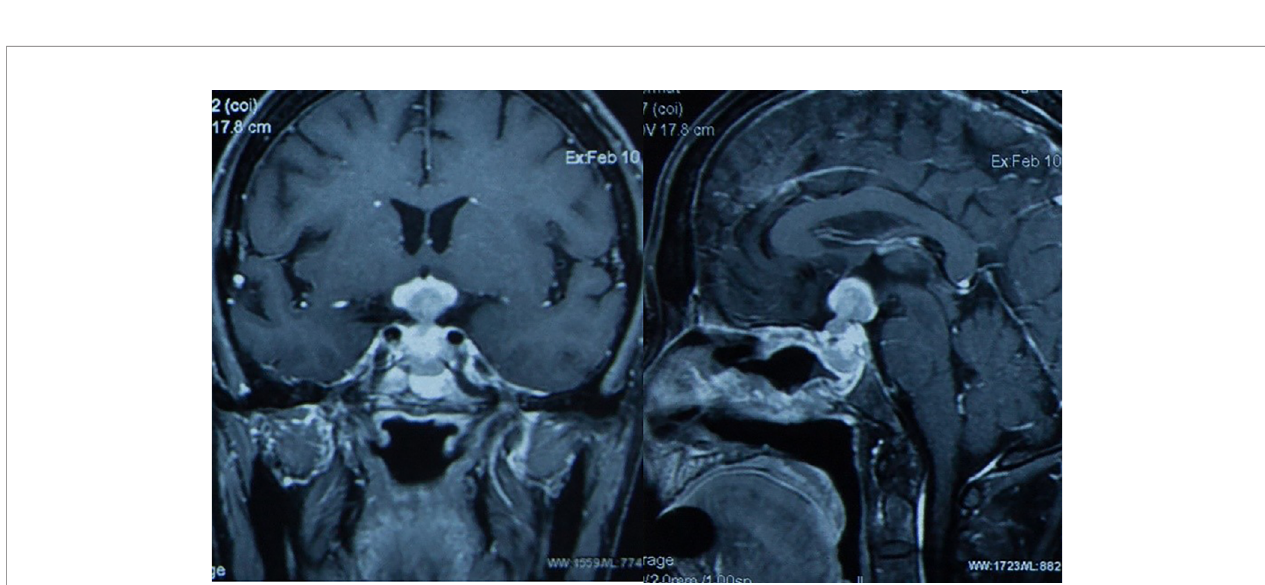
FIGURE 5 | Pituitary MRI at two months from the beginning of chemotherapy demonstrated the tumor (size of about 2 × 1.5 × 3.2 cm) was larger than before without cavernous sinus involving in Case